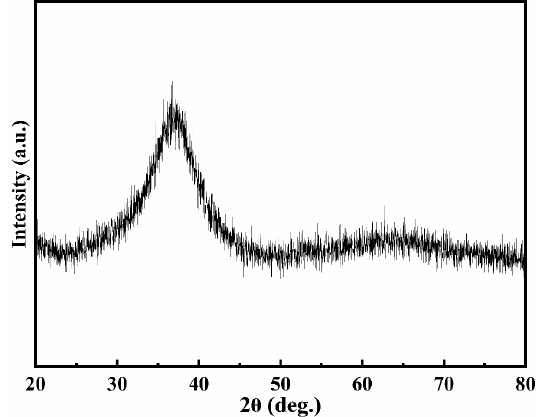
Figure 2. XRD pattern of (Cu 0.47 Zr 0.45 Al 0.08 ) 98 Dy 2 BMG.